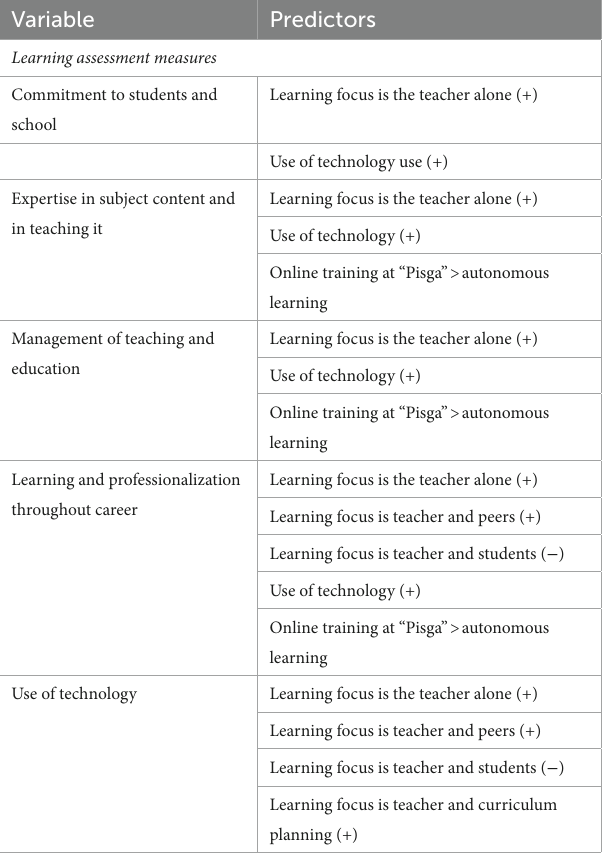
TABLE 5 Summary of predictors for the learning assessment measures in path analysis.